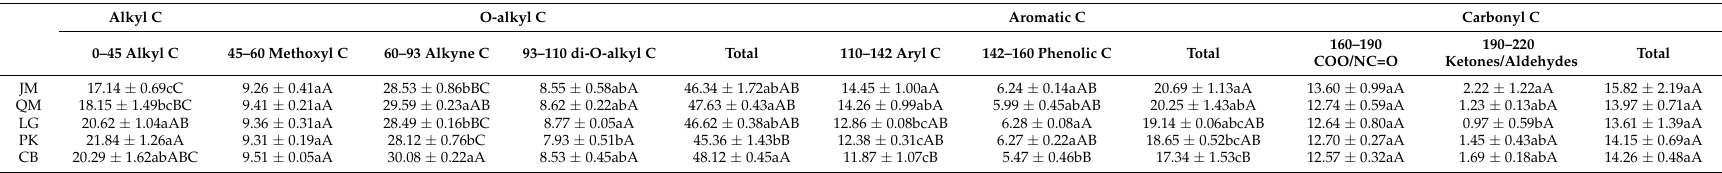
Table 2. Relative percent (%) of different SOC chemical functional groups from soil samples (0–10 cm depth) under different revegetation types. AlkylC